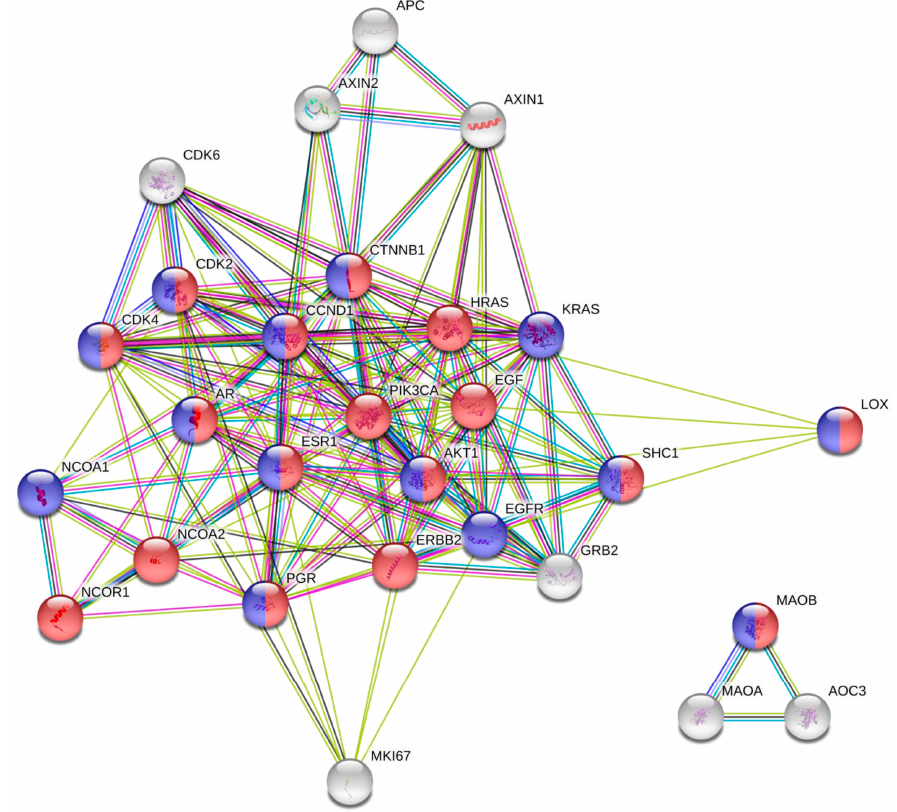
Figure 4. Functional analysis using STRING database. Using “Mutual Exclusivity” function, 3 significant gene pairs with mutually exclusive alteration were identified ( ERBB2-PGR , AOC3-ERBB2 , MKI67-ESR1 ) and 1 gene pair with concurrent alteration ( AOC3-MAOA ). The response to hormone stimulus (red) and the response to lipids (blue) include Lox and MAOB together with ESR1, suggestive of the presence of common activator of estrogen positive type of breast cancer.